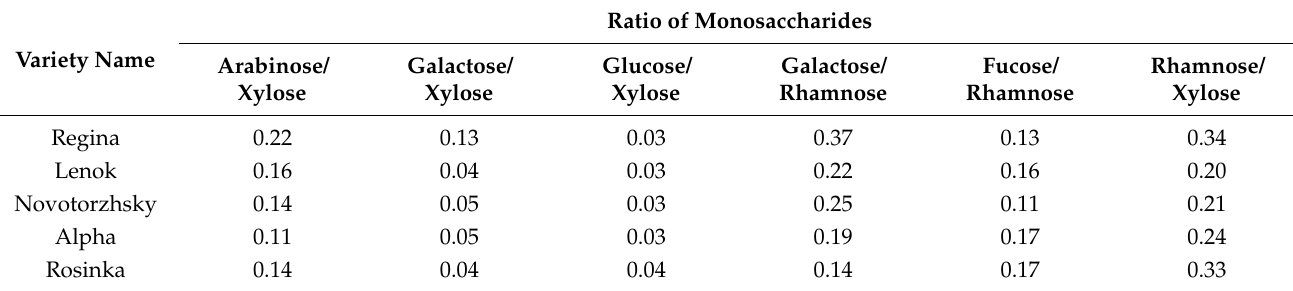
Table 6. The ratios of the contents of some monoses in mucus obtained from the seeds of fiber flax.